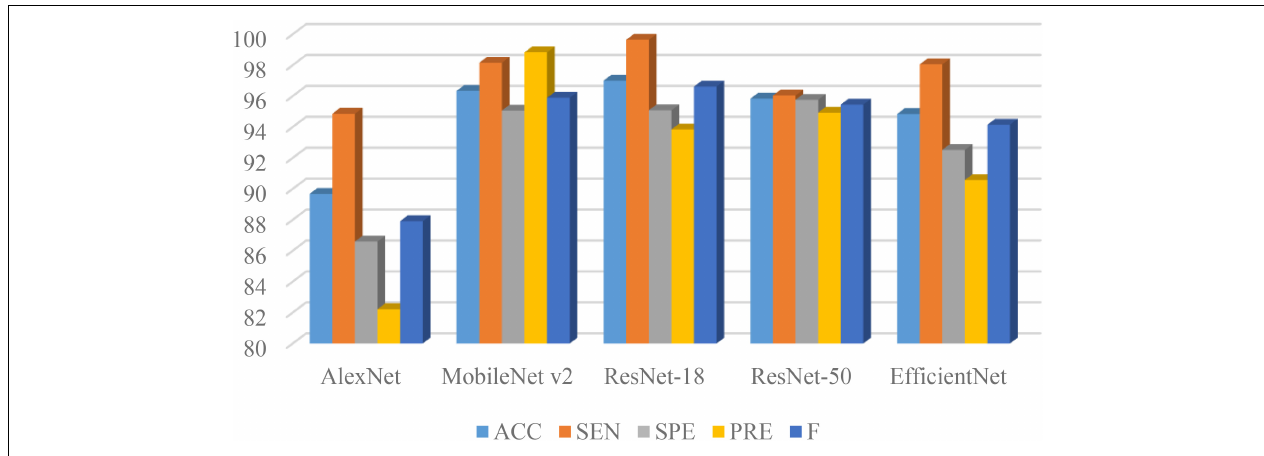
FIGURE 6 | Performance of the PBTNet with different backbones based on 5-fold cross-validation (unit: %).